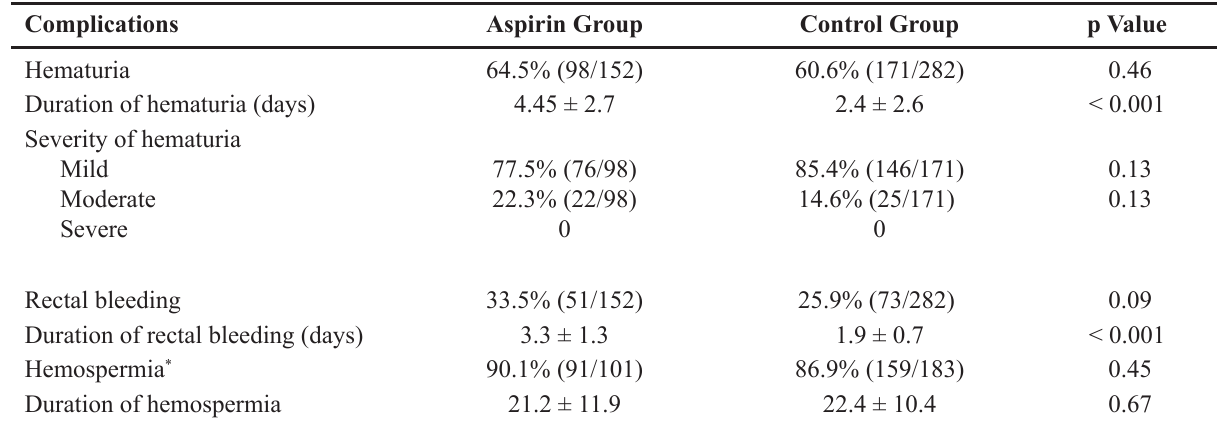
Table 2 – Incidence and duration of hemorrhagic complications.